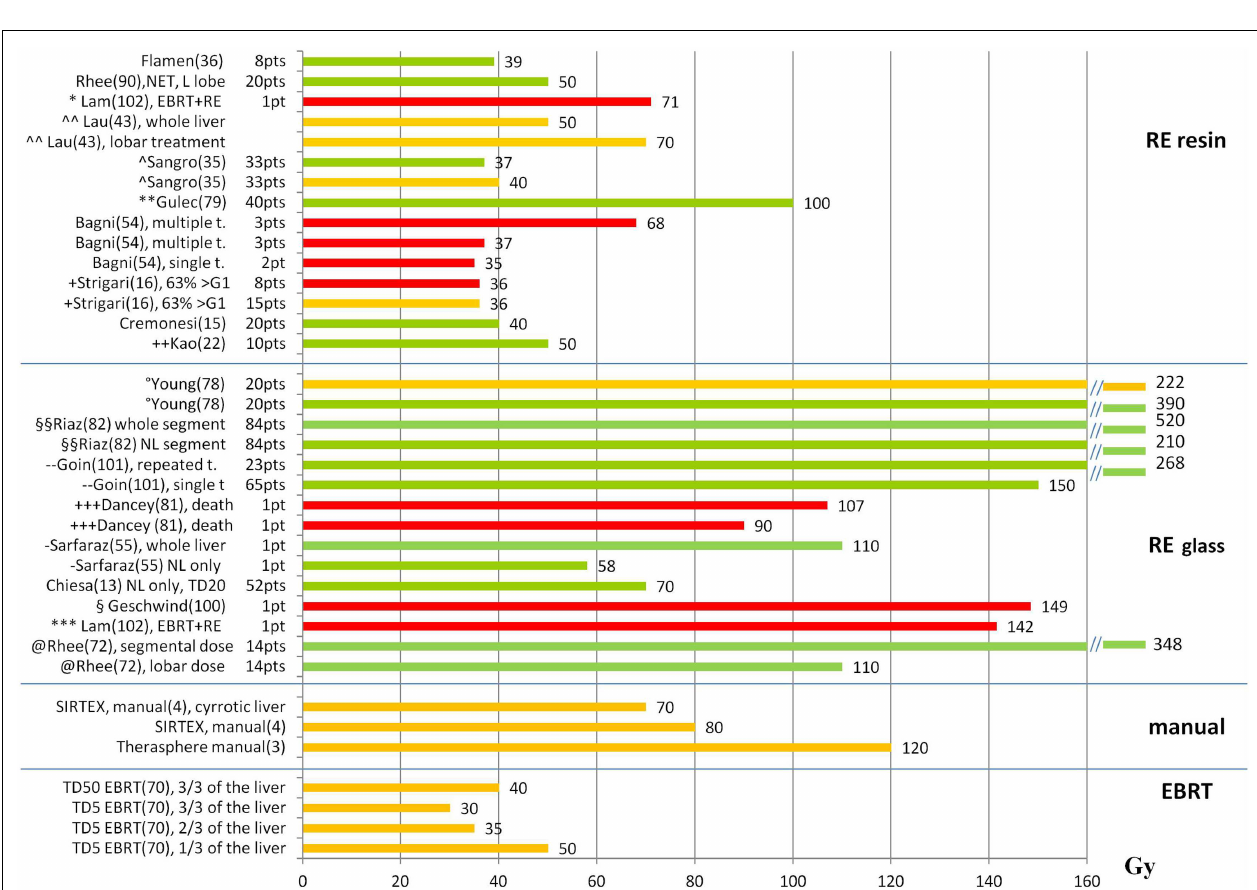
bar represents the median value of the interval (36Gy), ++ (22)WL treatment,°(79) O-I, HCC, multiple treatments, §§(80) HCC, segmental treatments, - -(81) HCC,WL, and lobar treatments. No use of REILD toxicity score, +++ (82) HCC, 9 O-I, 11 O-II, no distinction between tumor and NL dose, -(54) mean NL dose = 58Gy, §(83) patient receiving RE to the right lobe (139Gy) and the left lobe (158Gy).The bar represents the mean value between the right and left lobe, ***(77) patient with previous EBRT (23Gy) and RE to the right (111Gy) and the left (172Gy) lobe.The bar represents the mean value between the right and left lobe, @(84) HCC, segmental treatments,